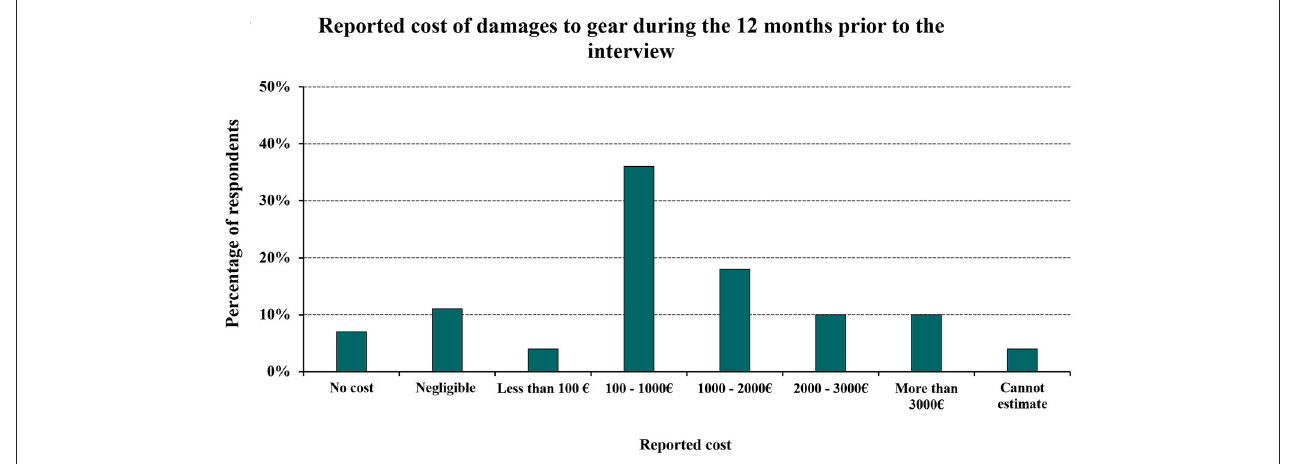
FIGURE 5 | Estimated cost of damages caused by sea turtles on Crete in the 12 months prior to the interview. Amounts are given in Euro ( e